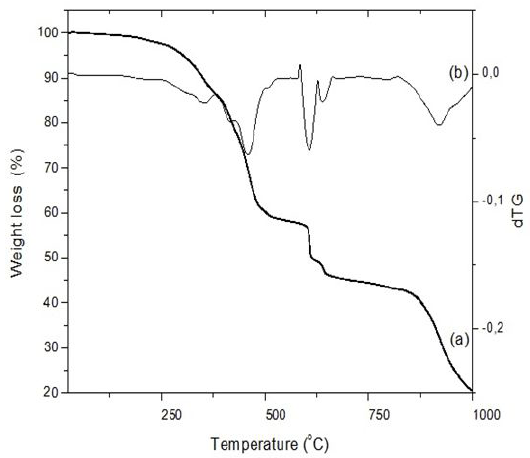
Figure 6. Thermogravimetric analysis (TGA) (a) and their first derivative (dTG) (b) of CoHo:PGLyD microspheres.